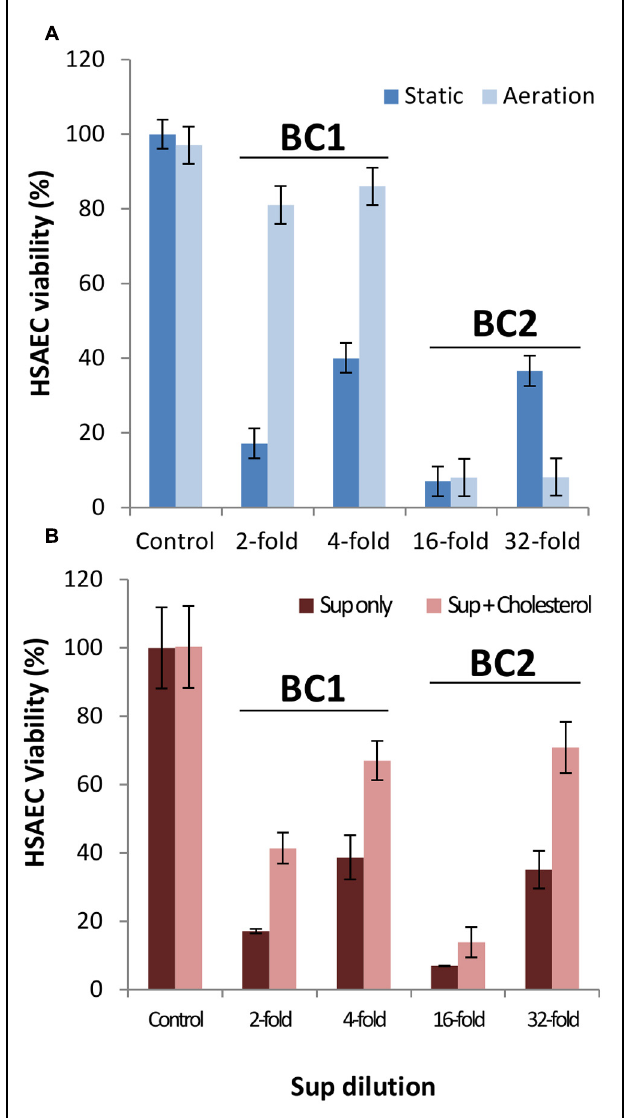
FIGURE 2 | BC1 and BC2 cultures accumulate high levels of toxicity when grown in microaerobic and aerobic conditions for 20 h (A). The toxicity of microaerobic Sup can be partially abrogated by cholesterol (B) . (A) BC1 and BC2 were cultured in CSFM as described in the Figure 1 legend. The Sups were collected, serially diluted in CSFM, and used to treat HSAECs for 20 min. The viability was assessed with resazurin relative to unexposed cells. (B) Where indicated, cholesterol was added to microaerobic Sups at 10 μ g mL − 1 for 1 h. For each strain the data for two dilutions in the dynamic range of the assay are shown.